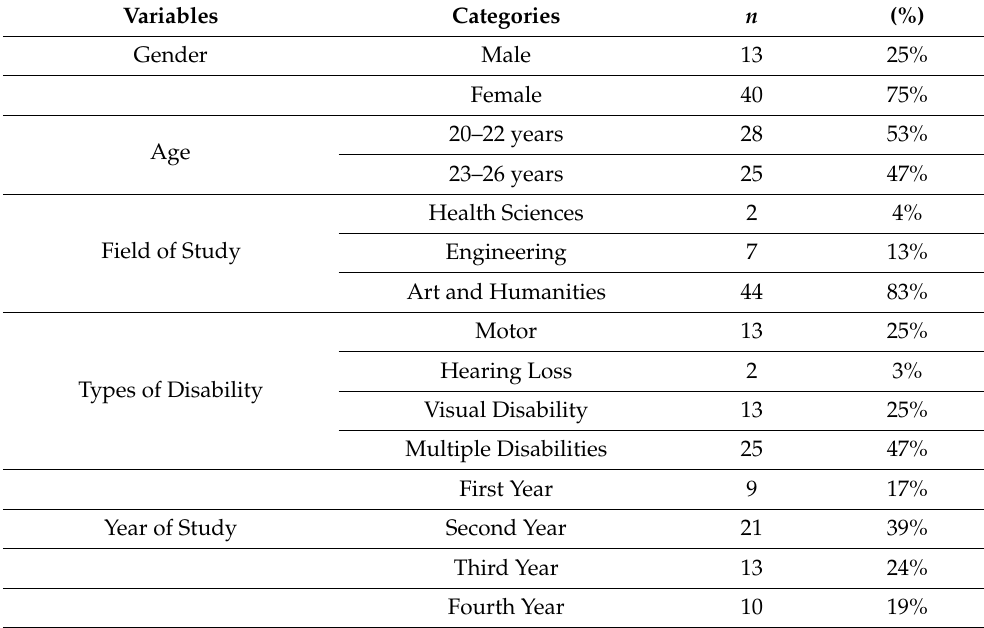
Table 1. Demographic characteristics of university students with disabilities (n =